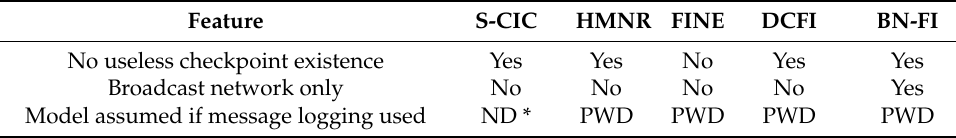
Table 1. Comparison with the other CIC representatives (* non-deterministic).